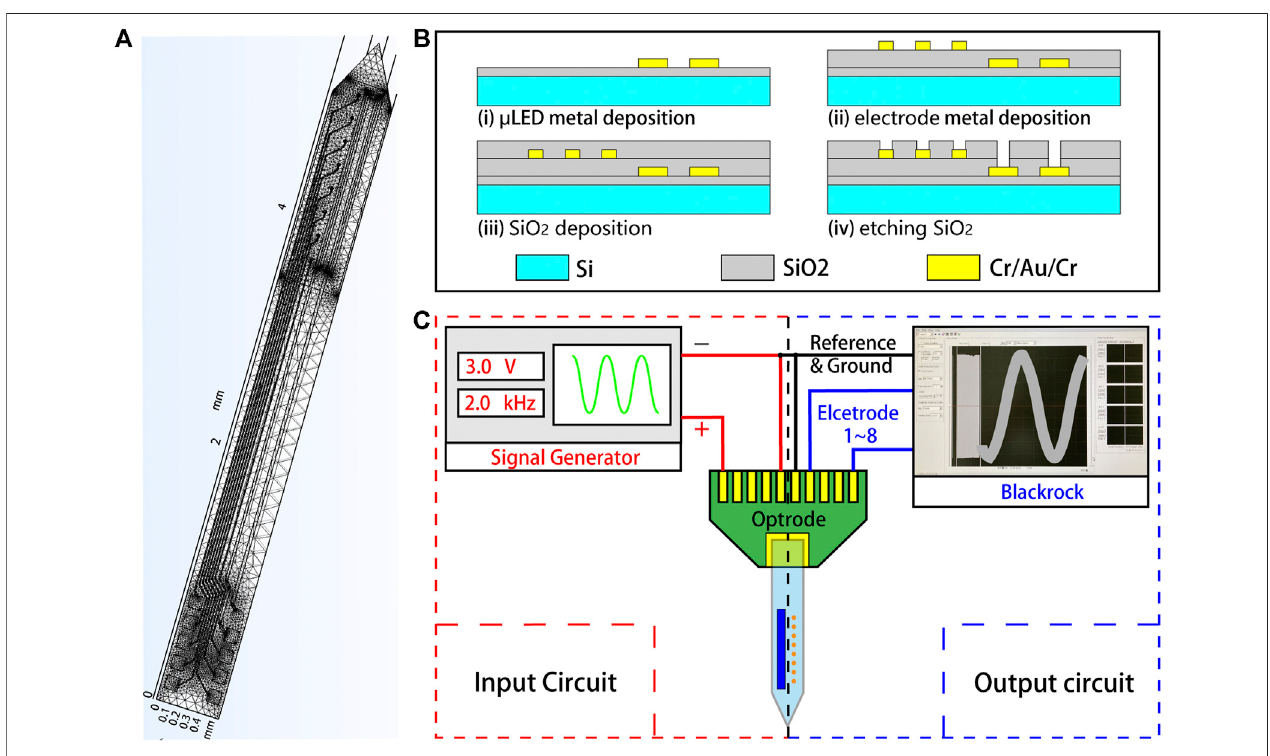
FIGURE2|(A) 3Dmodelmeshingofnoshieldingoptrode. (B) Partialprocess fl owofthesimpli fi edoptrode. (C) The invitro systemfortestingtheoptrodeshielding effect, consisting of a signal generator and a multi-channel recording